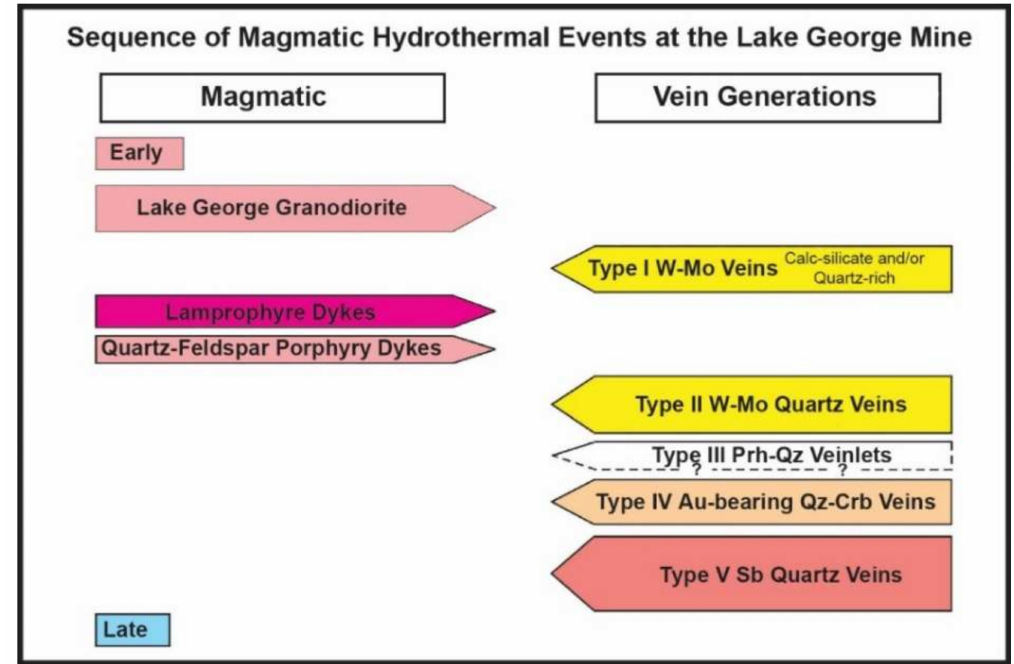
Figure 3. Schematic representation of the relative sequence of the magmatic hydrothermal events present in the area surrounding the Lake George antimony mine (modified from